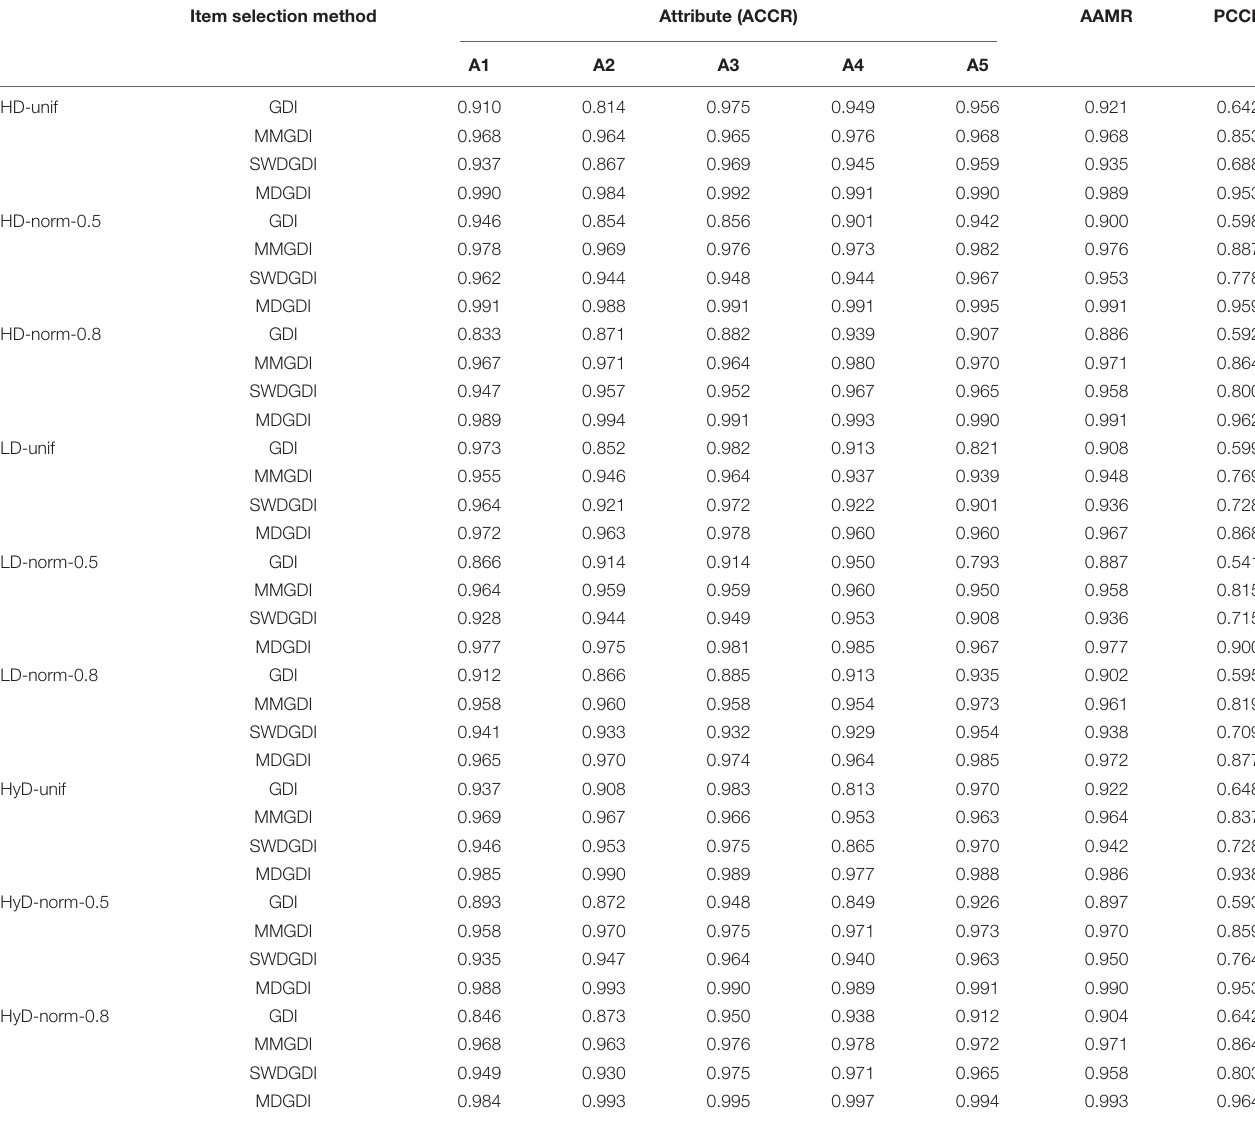
TABLE 3 | Accuracy of the attribute classification for five